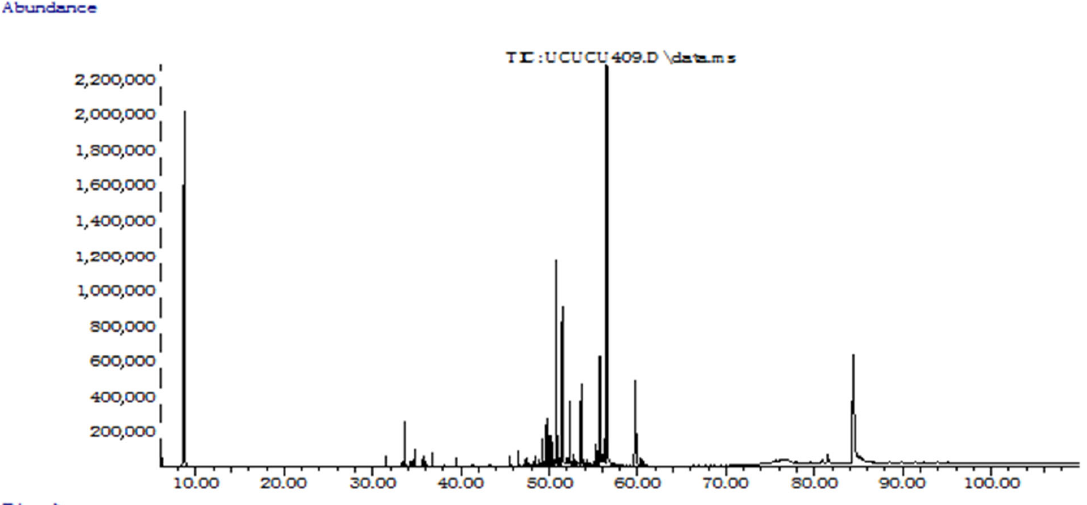
Figure 2. Total ion chromatogram of essential oil from root of Chrysopogon nigritanus .